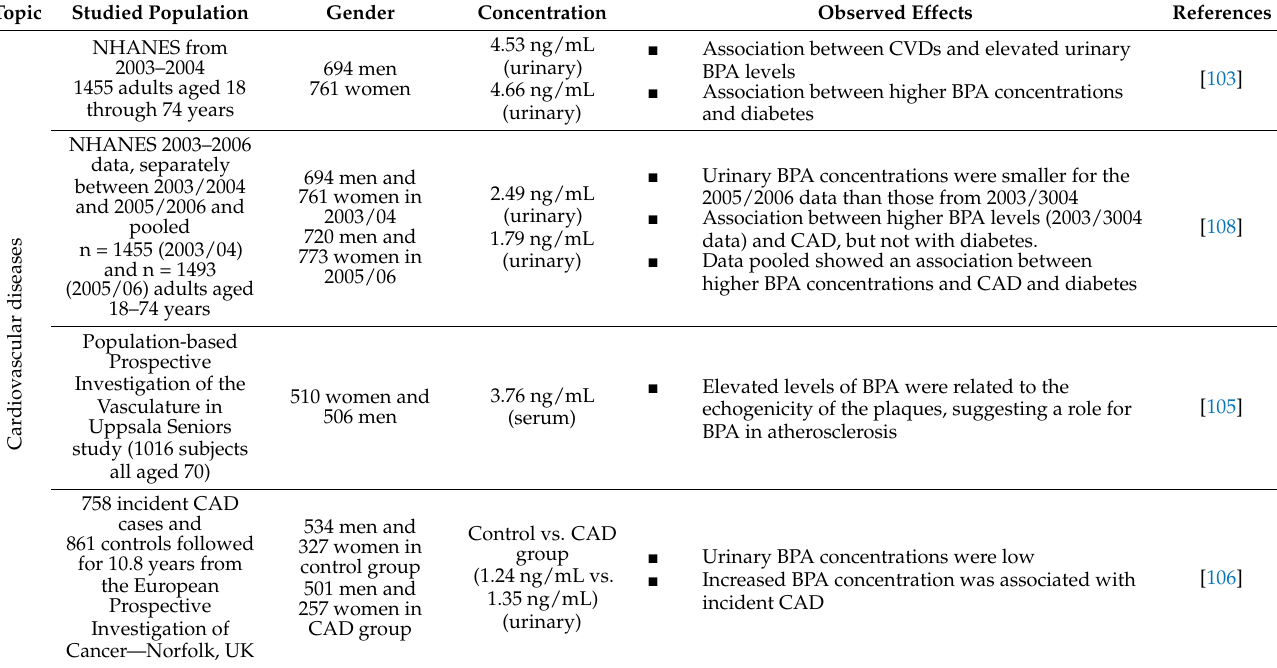
Table 5. Summaries of the disruptive effects of BPA in human epidemiological studies 1